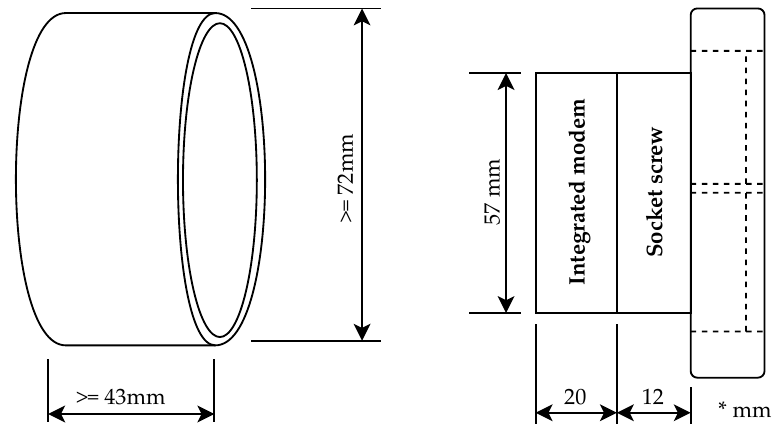
Figure 6. Wiring box and side view of integrated BPL